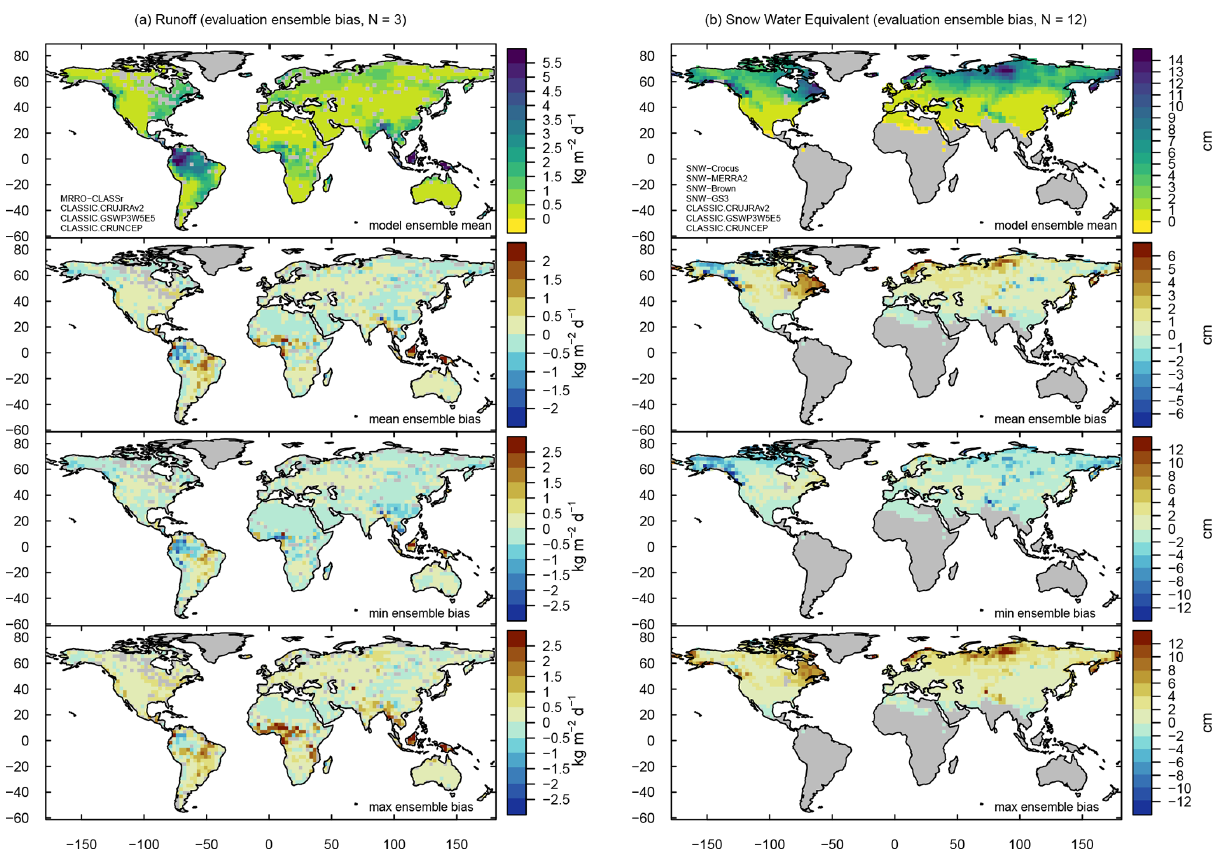
Figure A13. Same as Fig. 7 but for (a) runoff and (b) snow water equivalent.